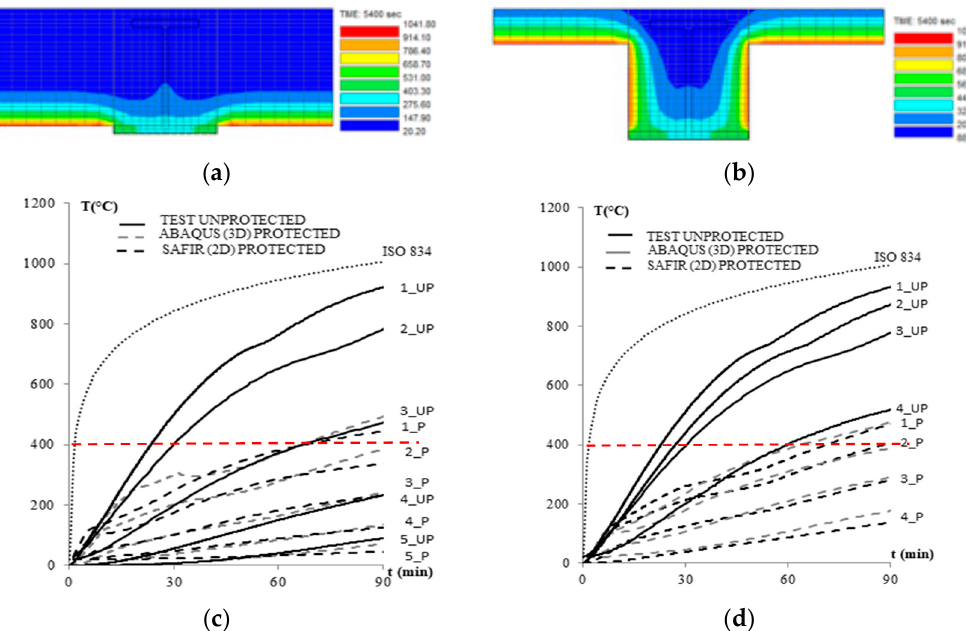
Figure 11. Effectiveness of IC in terms of temperatures predictions for protected vs. recorded for unprotected, WFRC 67756: ( a ) Thermal contours for the protected beam at section AA’ after 90 min, ( b ) Thermal contours for the protected beam at section BB’ after 90 min, ( c ) Protected vs. Unprotected at section AA’ ( d ) Protected vs. Unprotected at section BB’. As expected, it is found that the applied intumescent coating (1200 μ m) significantly restricts the temperature developments on the steel section when compared to those recorded for the unprotected ASBs. The parts of the steel beam section which are closer to